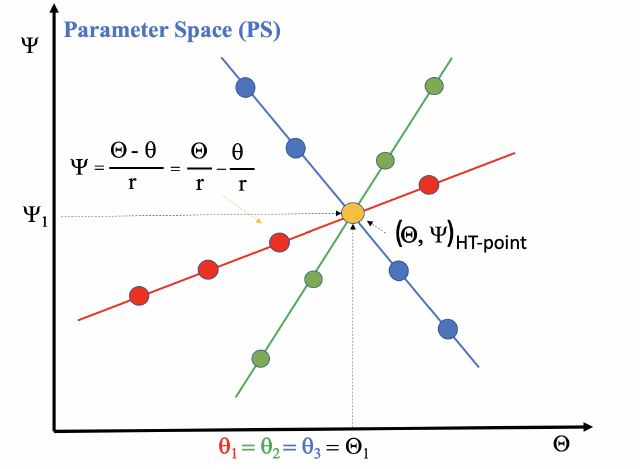
Figure 2. Parameter Space after executing HT Formula